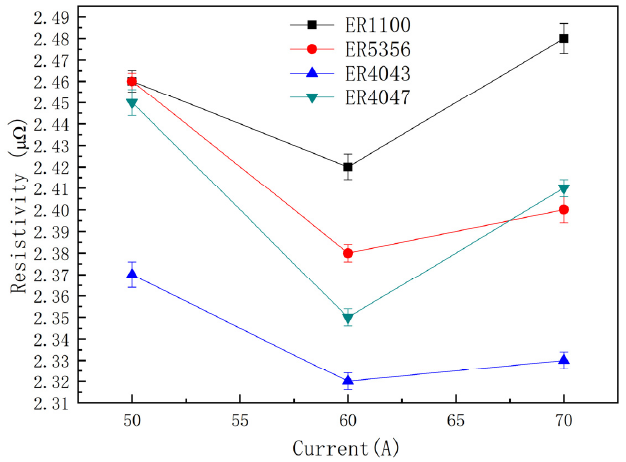
Figure 9. Resistivity of joints in different heat input.